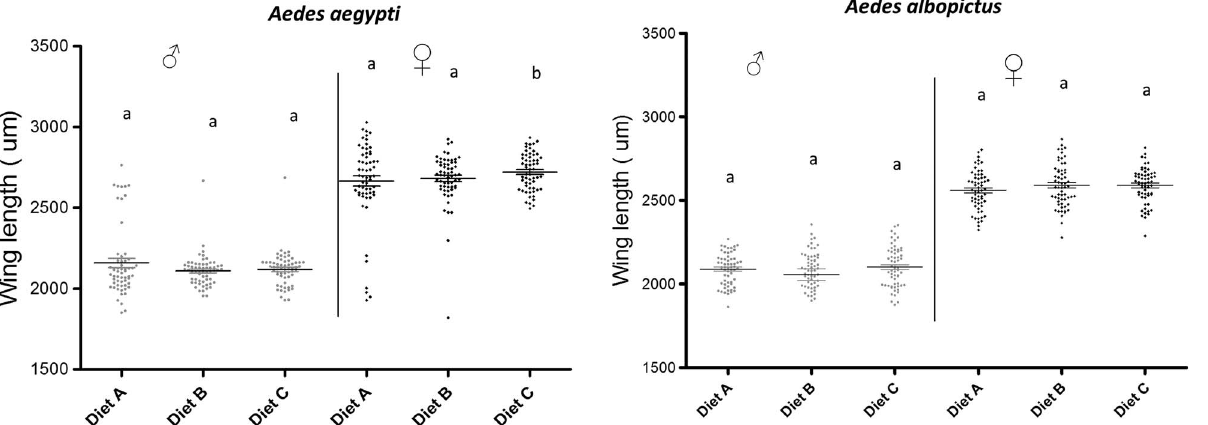
Figure 4. Wing length of male and female Aedes aegypti and Aedes albopictus reared from L1 with different larval diets. Different letters indicate signi fi cantly different results between treatments, by sex. Points represent individuals and the horizontal bar the mean. Diet A = 50%